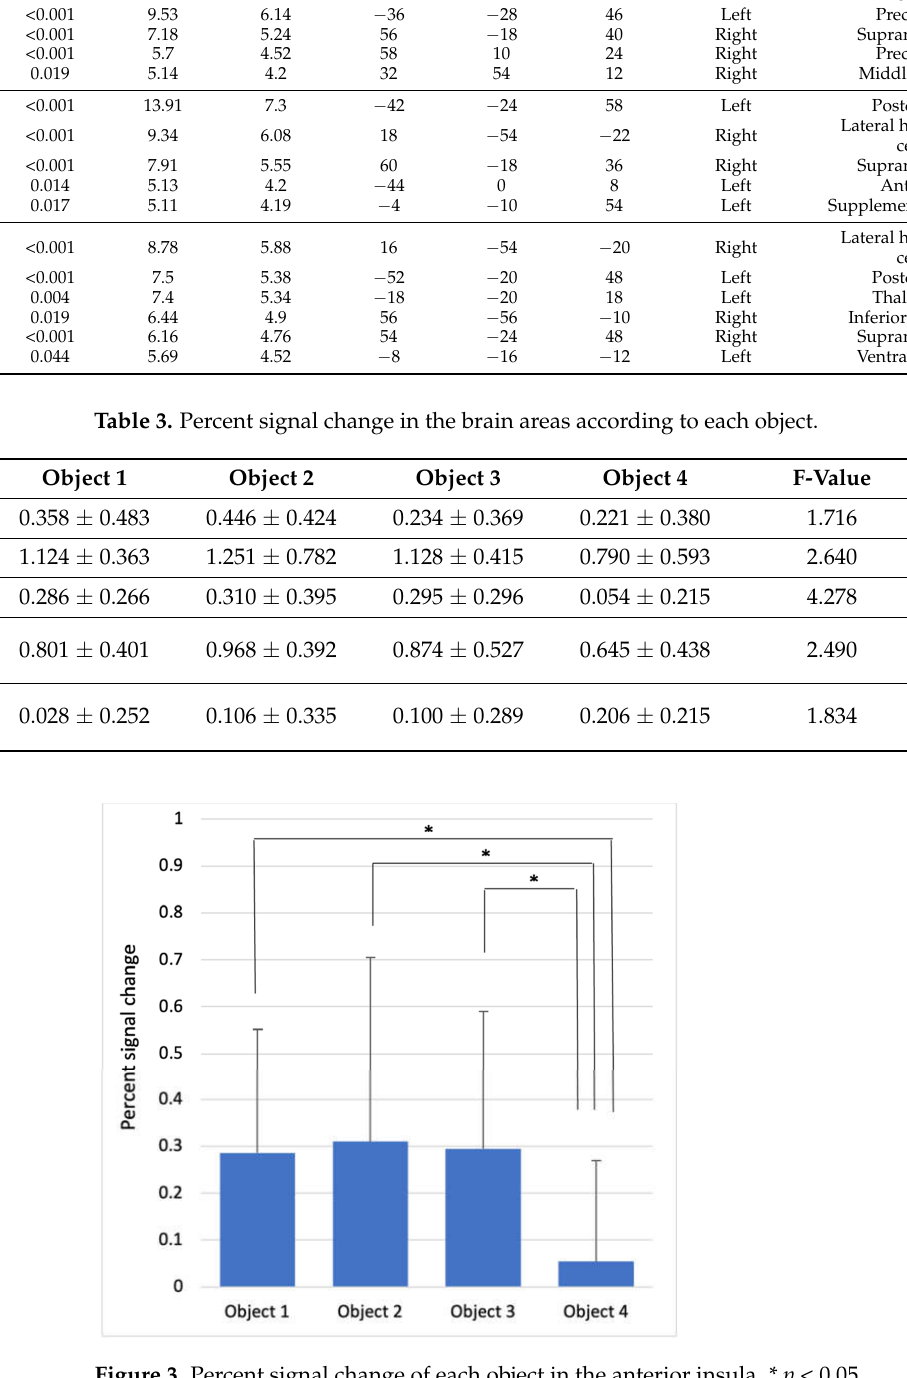
Figure 3. Percent signal change of each object in the anterior insula. * p < 0.05